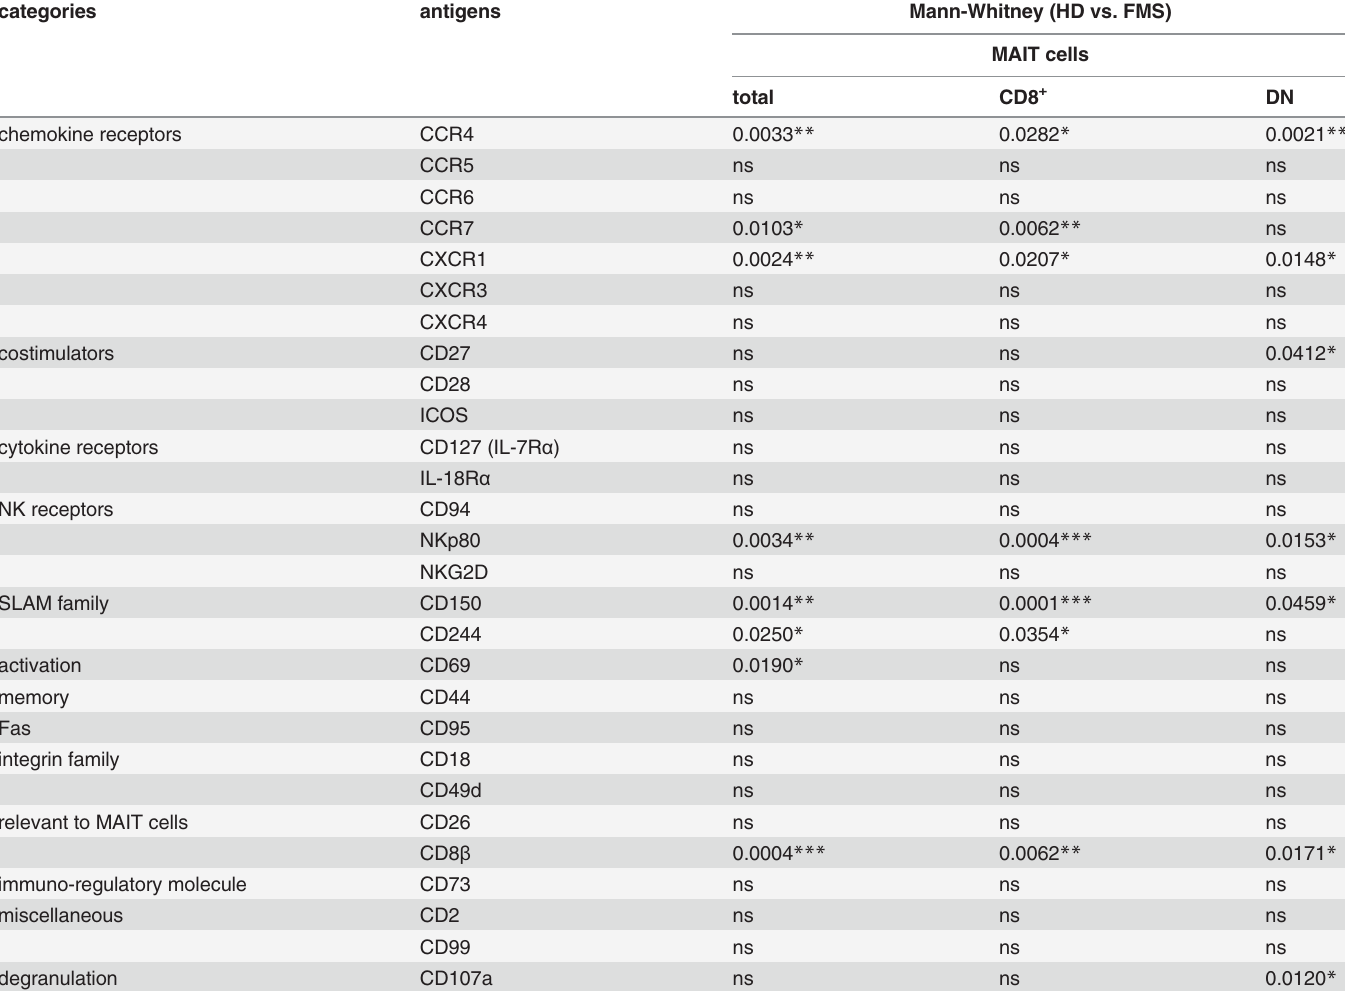
Among the cell surface molecules so far studied, CD94 in total and DN MAIT cells, and CXCR1 in DN MAIT cells, would allow the distinction between RA and SpA (Fig. 3 and Table 3 and S3 Table). Analysis of serum showed that RA had elevated levels of C-reactive protein (CRP) com- pared with FMS and/or SpA (Fig. 4A and S4A – B Table). Matrix metalloproteinase (MMP)-3 level in FMS was significantly lower than that in RA and SpA (Fig. 4A and S4A – B Table). Table 2. Cell surface antigens showing a difference in expression in MAIT cells between HD and